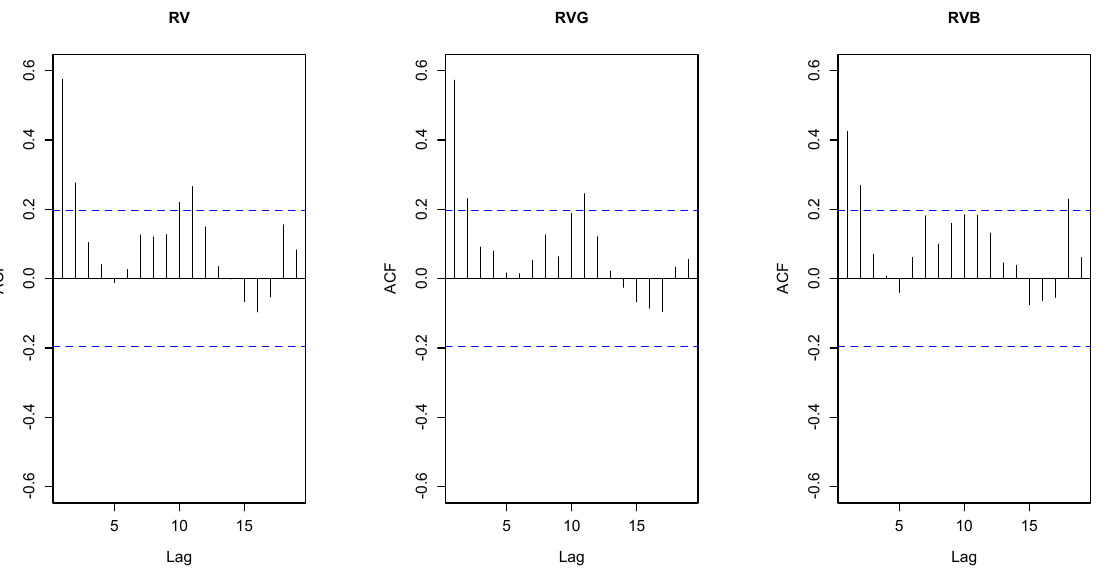
Figure 2. Autocorrelation Functions. Note: RV: Realized variance. RVB: Downside (“bad”) realized variance. RVG: Upside (“good”) realized